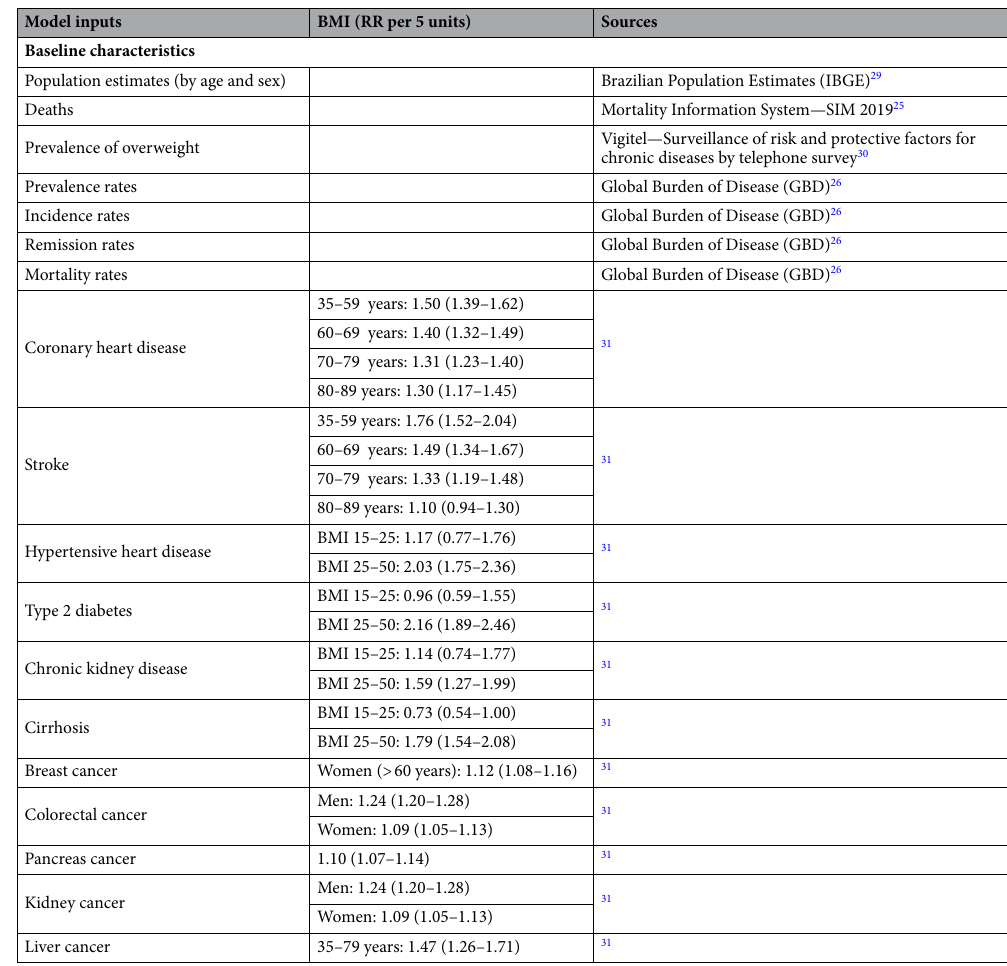
Table 1. Proportional multistate life table model input parameters to estimate the burden of non- communicable diseases from 2021 to 2030 attributable to changes in the prevalence of overweight and obesity in